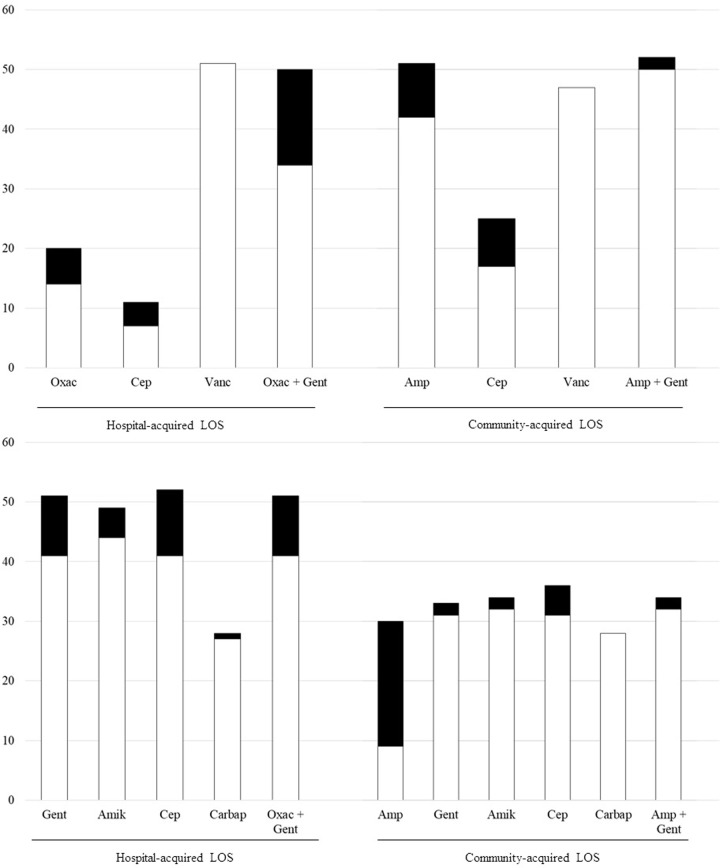
Sensitivity and resistance of gram positive (panel A) and gram negative (panel B) pathogens as a whole. Amp, ampicillin; Gent, gentamicin; Cep, third generation cephalosporins; LOS, late-onset sepsis; Oxac, oxacillin; Vanc, vancomycin. White columns, sensitive. Black columns, resistant or intermediate.